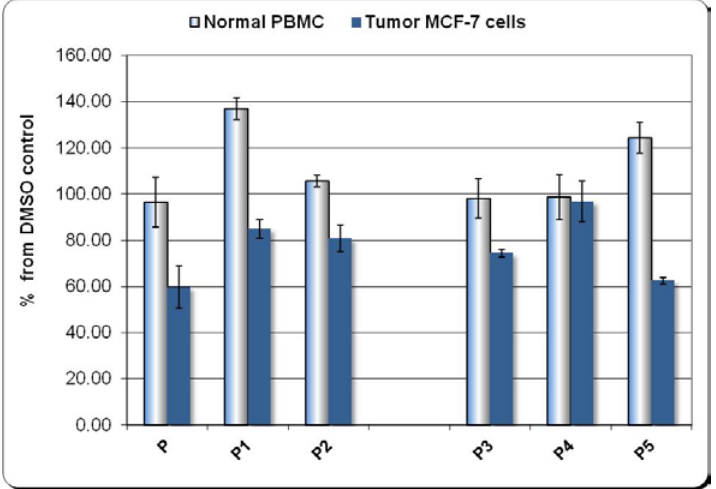
Figure 5. The effect exerted in vitro by the groups of compounds P , P1 , P2 and P3 , P4 , P5 on the number of metabolically active cells in culture, either on normal human peripheral mononuclear cells (PBMC), or on human breast carcinoma MCF-7 cells. Evaluation by the MTS reduction test. Results were presented as percentage of MTS reduction in presence of compounds from the corresponding DMSO-induced MTS reduction (mean ± SEM for three independent